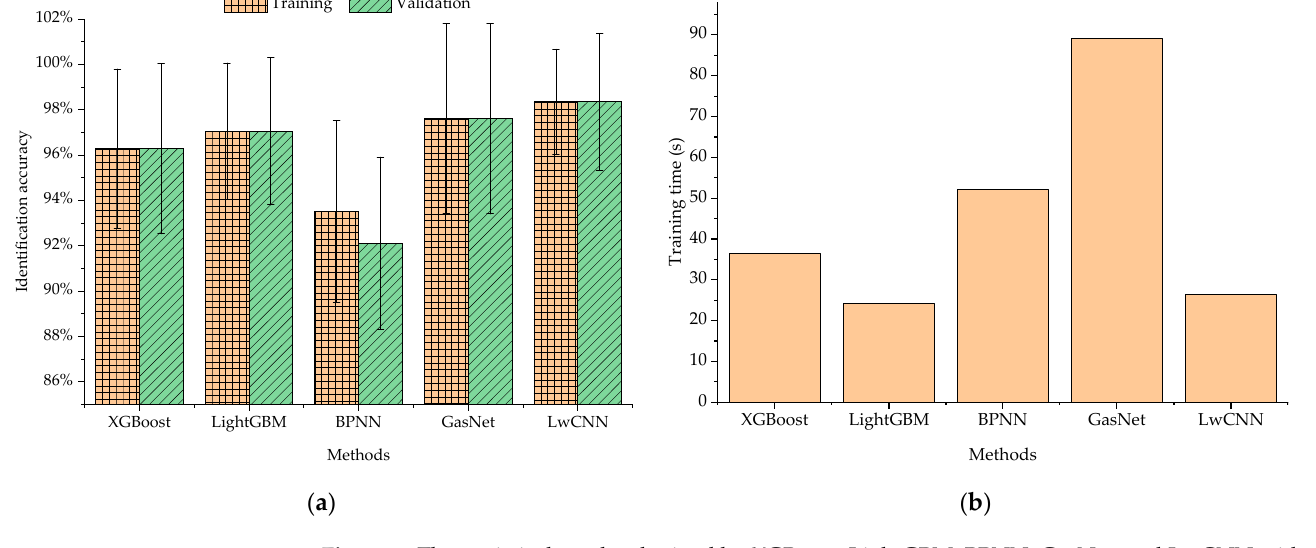
Figure 6. The statistical results obtained by XGBoost, LightGBM, BPNN, GasNet, and LwCNN with the same sampling dataset: ( a ) The mean and standard deviation of identification accuracies; ( b ) The mean and standard deviation of time spent for model training.